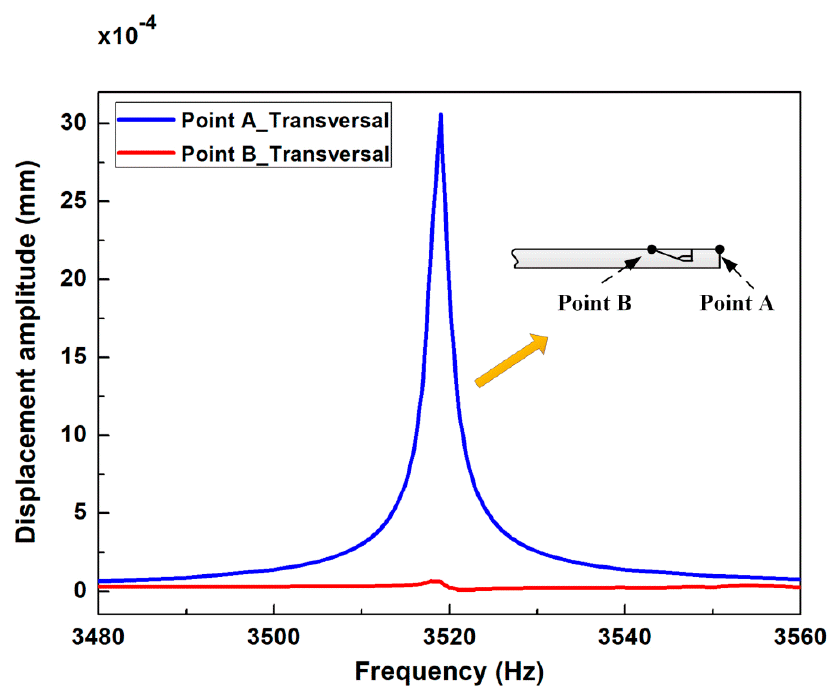
Figure 4. The transverse amplitude of an actuator with a beam tip of 7 mm.